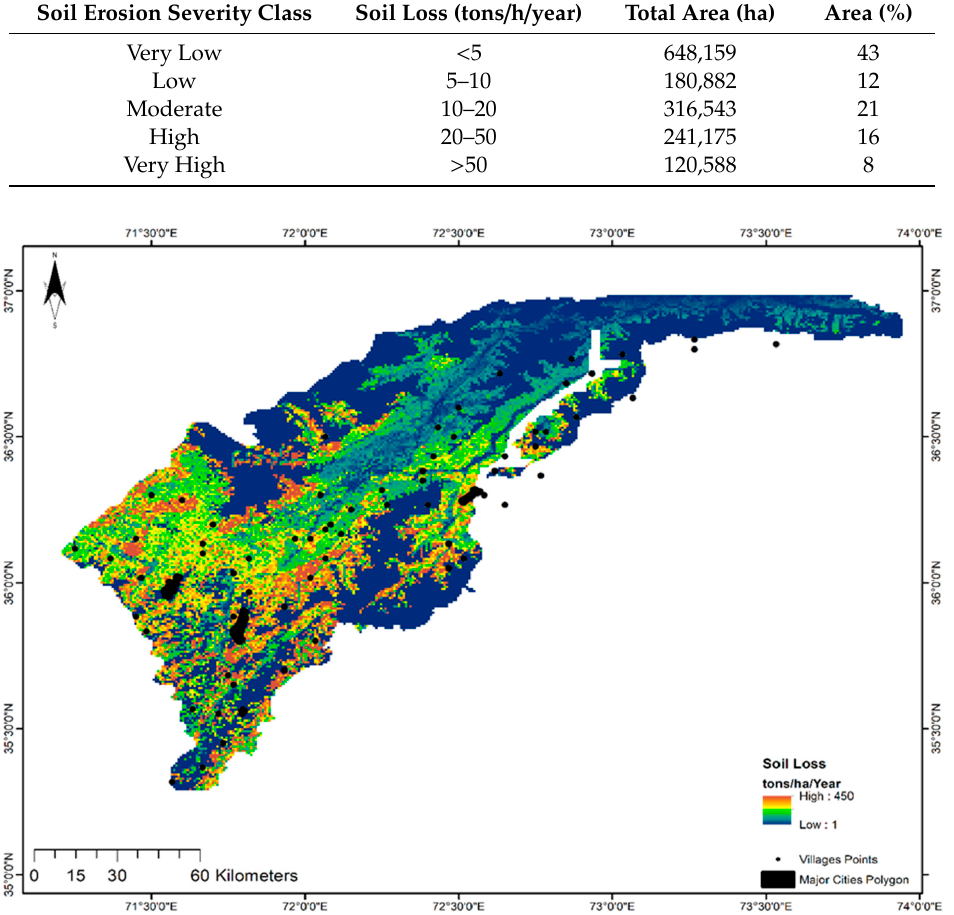
Figure 6. District map for soil loss.